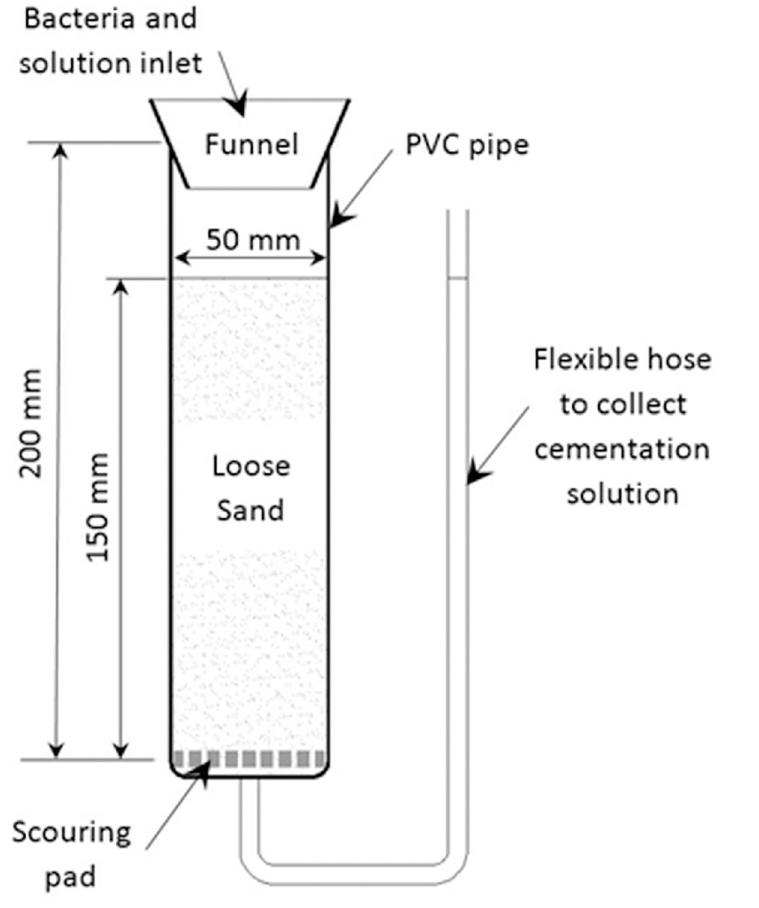
Fig 2. Schematic of the experimental setup of the sand